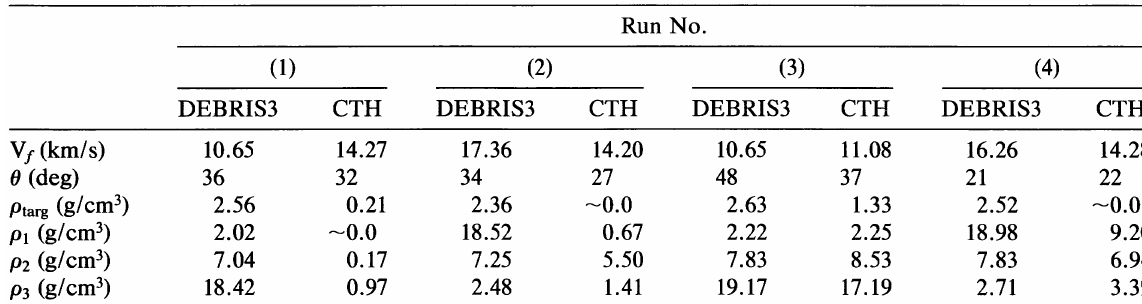
Table 3. Comparison of DEBRIS3 and crn Impact Response